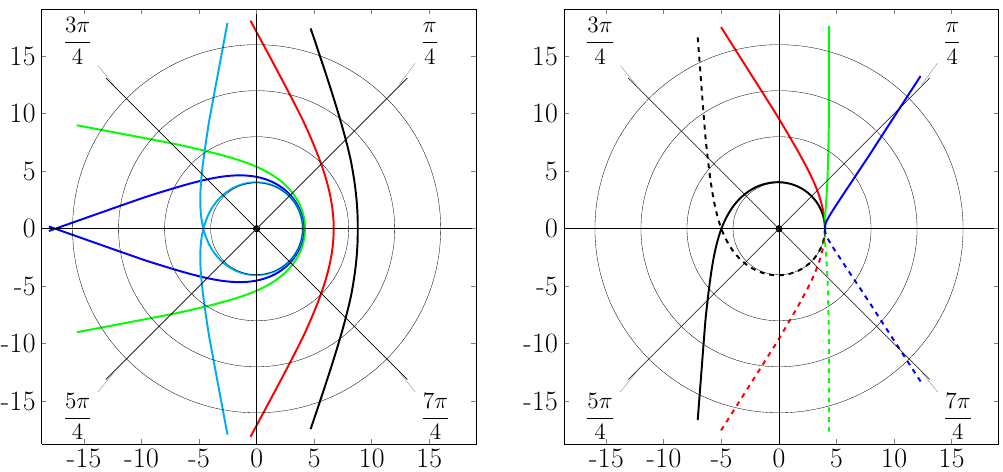
Figure 5. Photon trajectories of massive test particles for ansatz (28) with a = 1. In the left plot: b = 10 (black line), b = 8 (red line), b = 5.8 (green line), b = 5.7 (blue line), b = 5.66 (cyan line). In the right plot: b = 5.65 (black line), b = 5 (red line), b = 4.2 (green line), b = 3 (blue line). The dashed parts of lines represent the parts of trajectories located in the region r < 0.